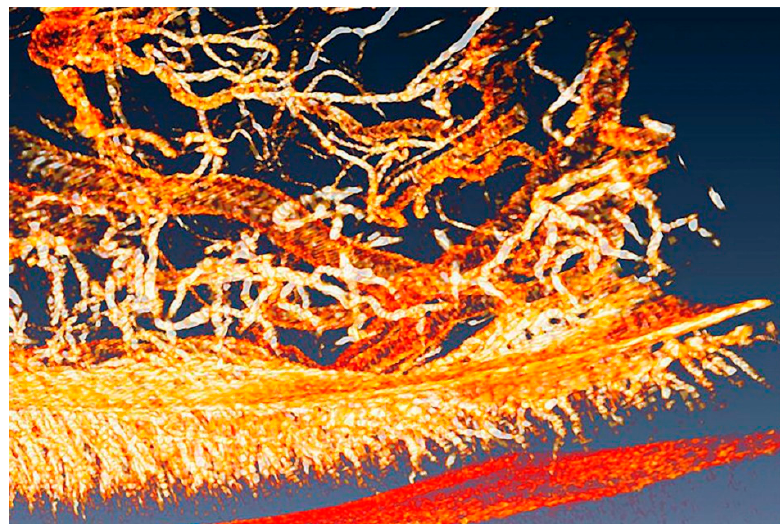
Figure 21. The complicated organ that provides the gas flow for the luminescence of fireflies. Phase- contrast radiography revealed even the smallest tubes, allowing reliable quantitative estimates [28]. Vertical image size ≈ 4 mm.